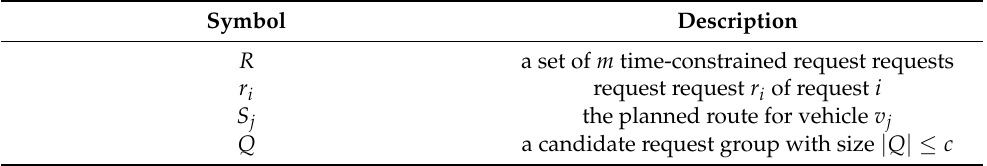
Table 2 summarizes the commonly used symbols. Table 2. Symbols and